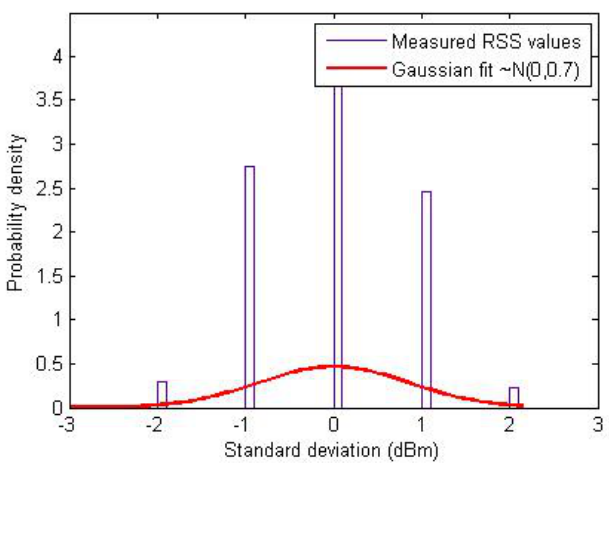
Figure 6. Histogram of RSS